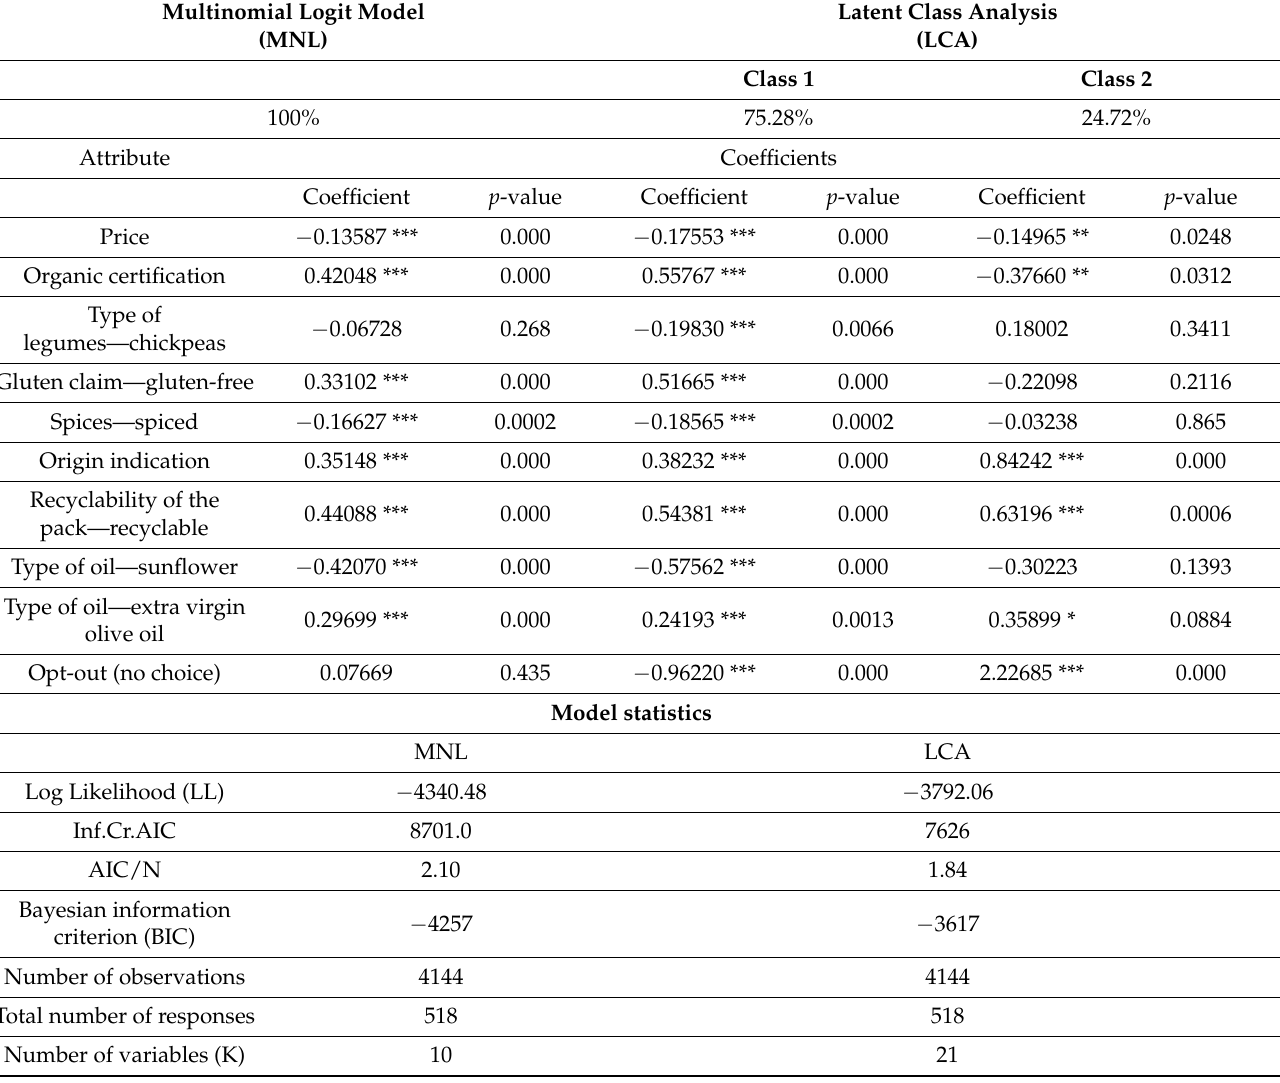
Table 9. Multinomial logit model (MNL) and latent class analysis (LCA)